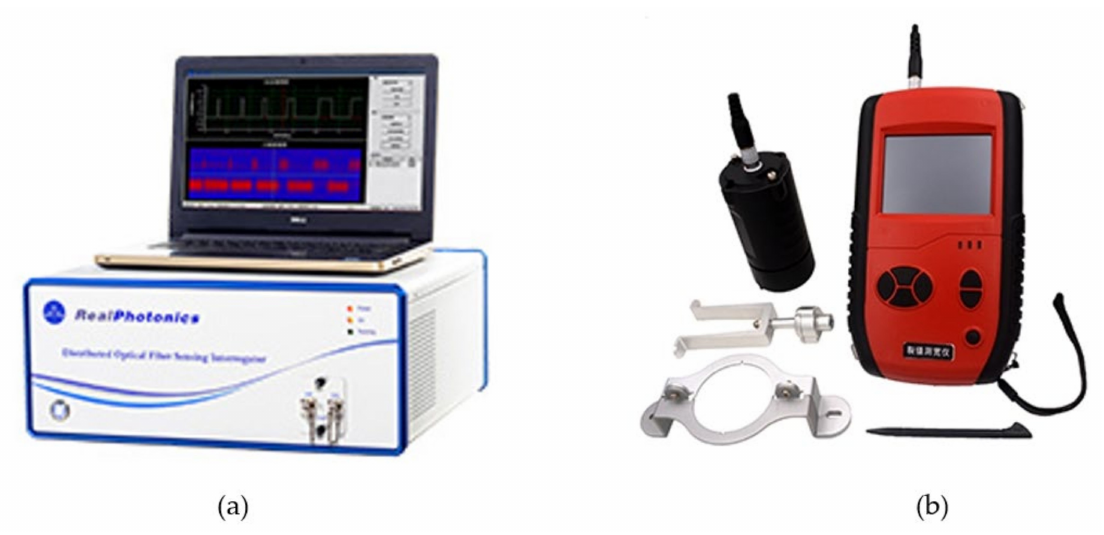
Figure 19. Measuring equipment ( a ) RP1002 high spatial resolution DPP-BOTA demodulator ( b ) ZP-CK103 structural crack width meter.